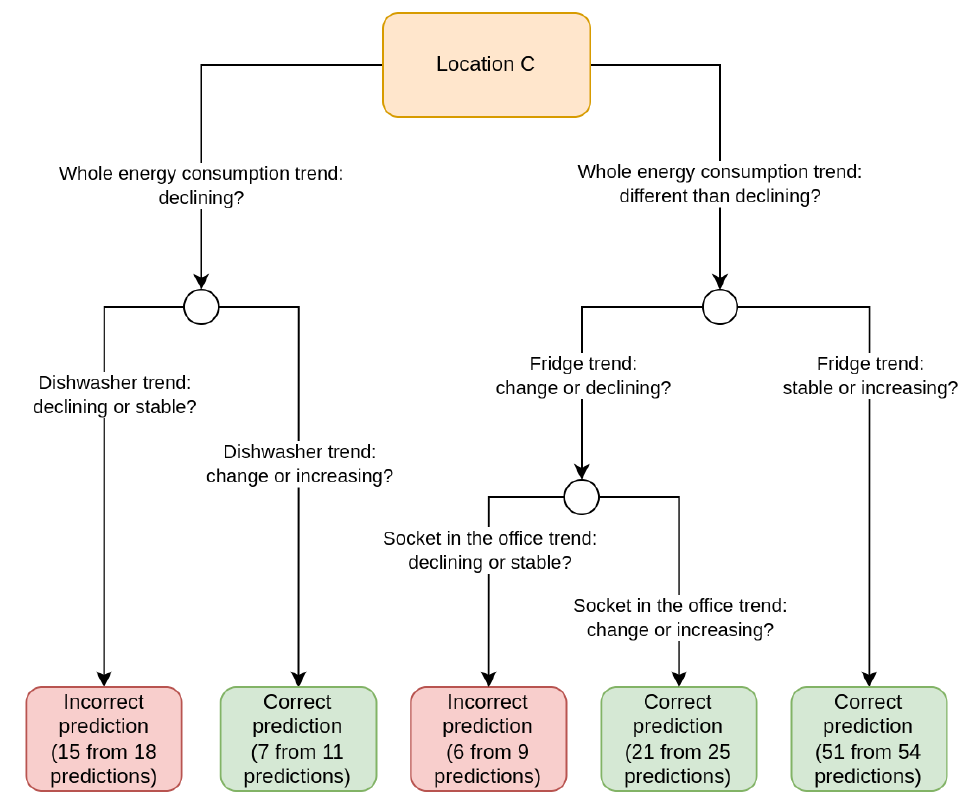
Figure 4. Decision tree explaining when the device_prophet models made mistakes for location